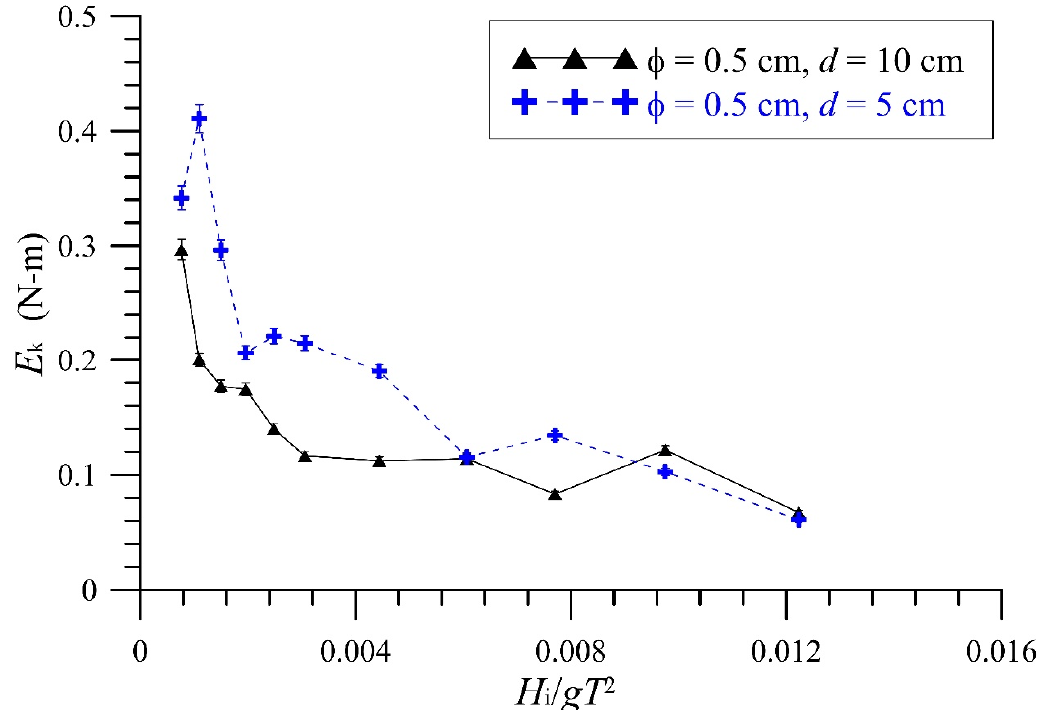
Figure 20 . Kinetic energy variations of various waves passing through vegetated areas (vegetation height of d = 5, 10 cm and fixed plant stem of ϕ = 0.5 cm) .